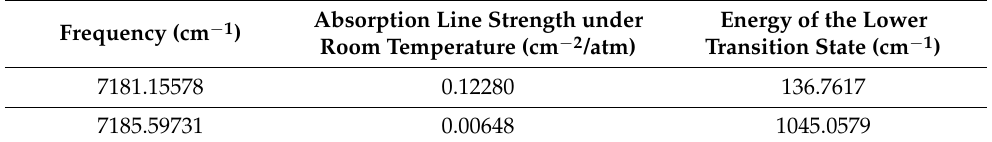
Table 3. Parameters queried and calculated from HITRAN.